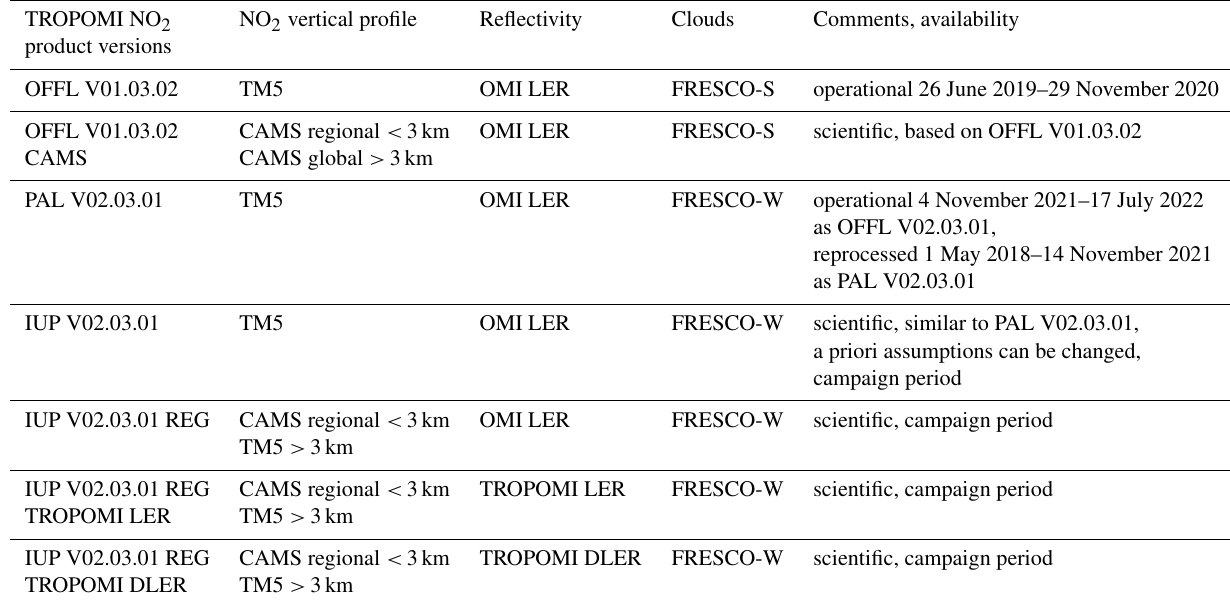
Table 3. TROPOMI NO 2 product versions with the most important differences between the analyzed products. TROPOMI NO